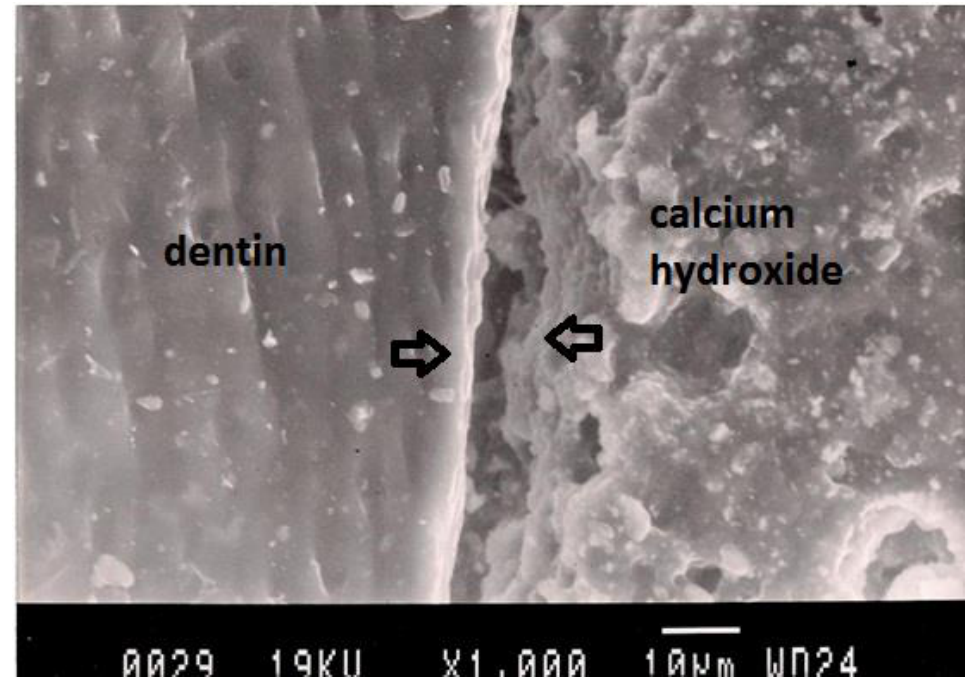
Figure 3. Representative SEM photomicrograph of a Group 2 specimen. The arrows indicate microgap between calcium hydroxide and